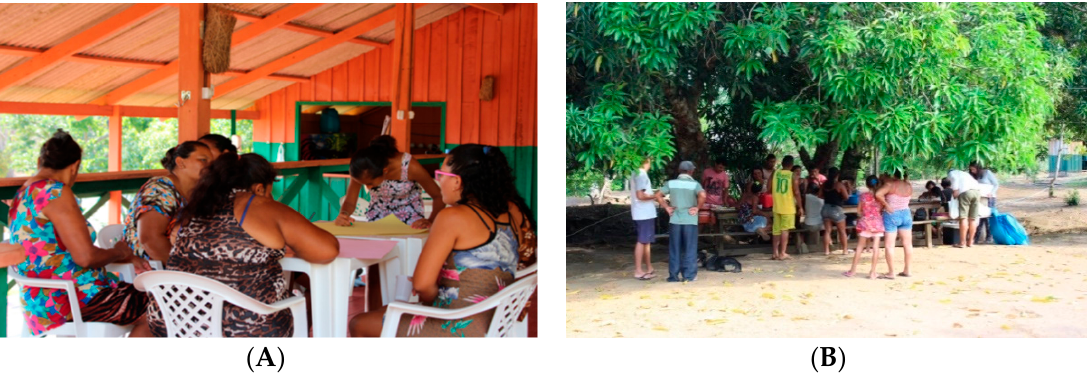
Figure 2. ( A ) community women from Tiririca; and ( B ) community men in Maraja. Figures are created by authors, obtained and used with permission.